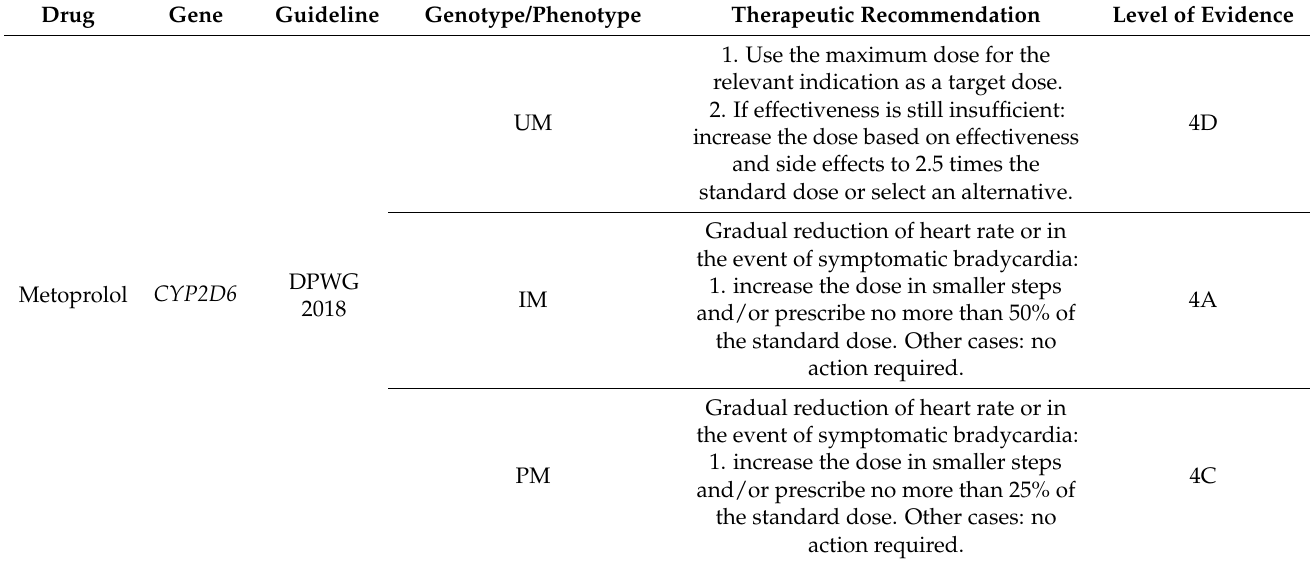
Table 5. Drug-gene pairs and dose recommendations by different clinical guidelines. Beta-blockers. Drug Gene